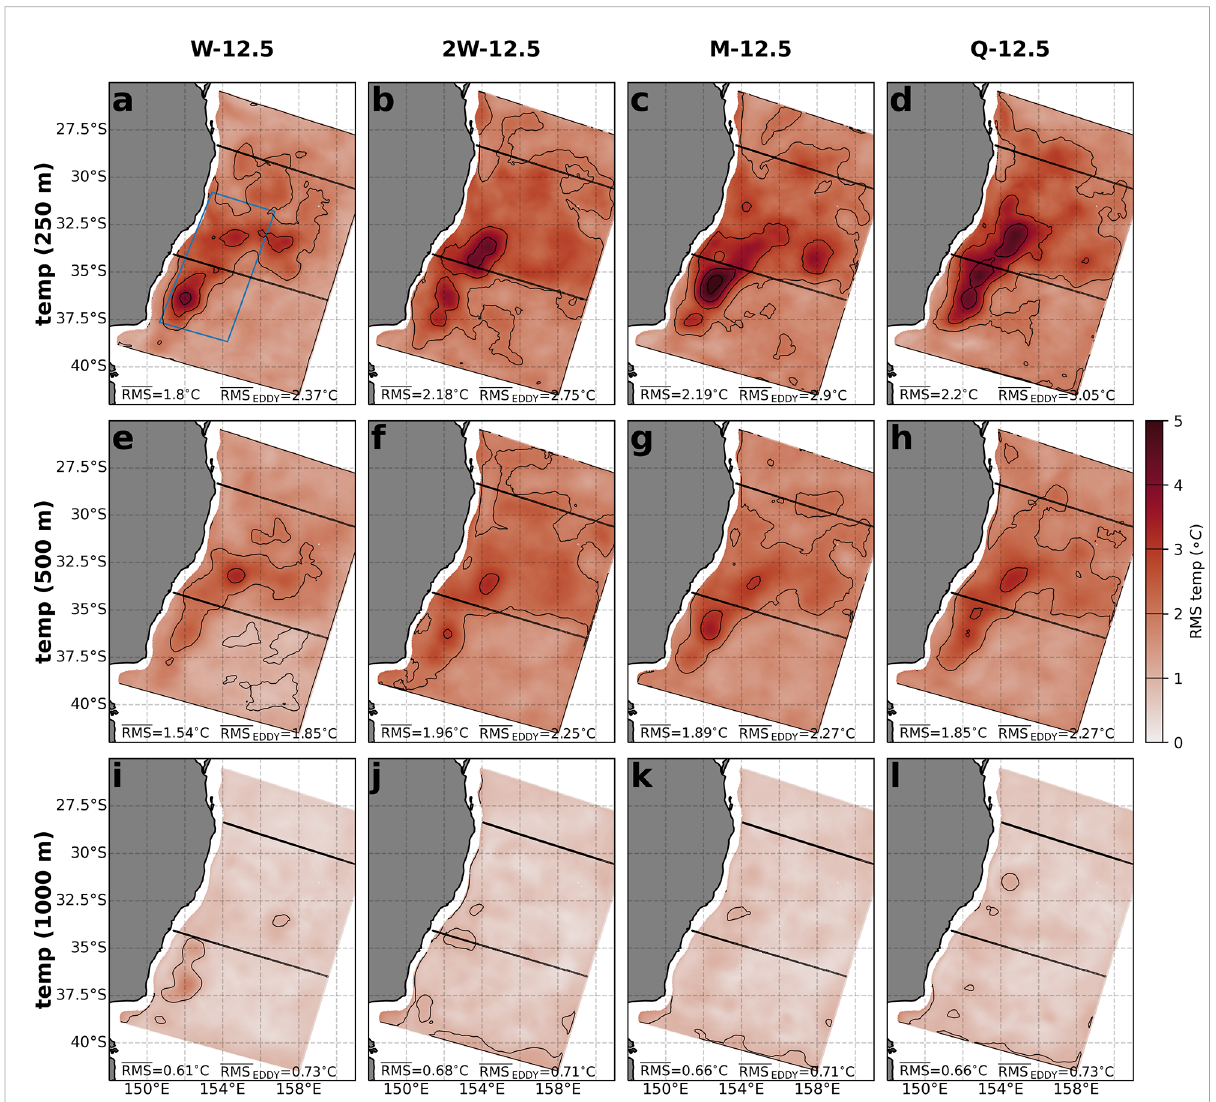
FIGURE 7 The RMS error in temperature, calculated for the time-mean, at depths of (A – D) 250 m, (E – H) 500 m, and (I – L) 1000 m, for the four different OSSEs: (A, E, I) Weekly 12.5 km, ( B, F, J ) Two-weekly 12.5 km, ( C, G, K ) Monthly 12.5 km and (D, H, L) Quarterly 12.5 km. RMS error is relative to the ref state, and mean values are shown in each panel for the full domain and the eddy-rich region designated by the blue box in panel (A) . The contour interval of 1°C is indicated with marks in the